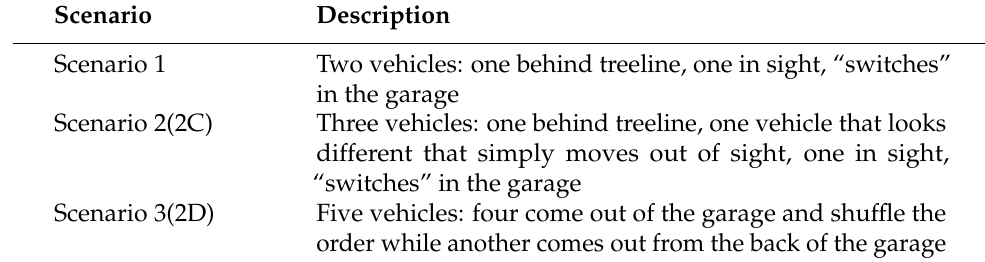
Table 1. Scenario